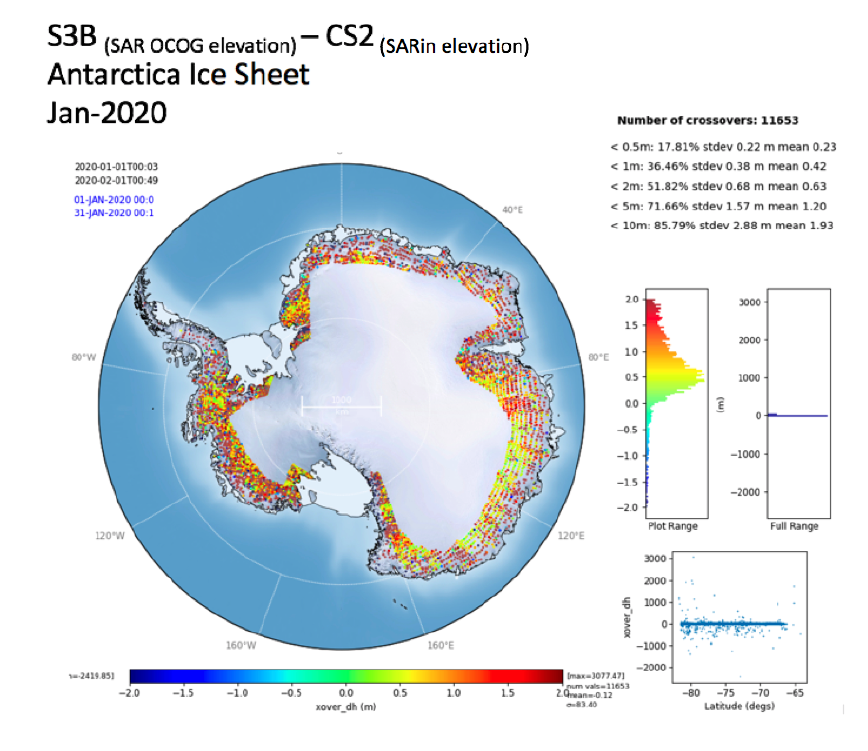
Figure 39. Comparison of S3B with CryoSat-2 (SARin mode) over Antarctic